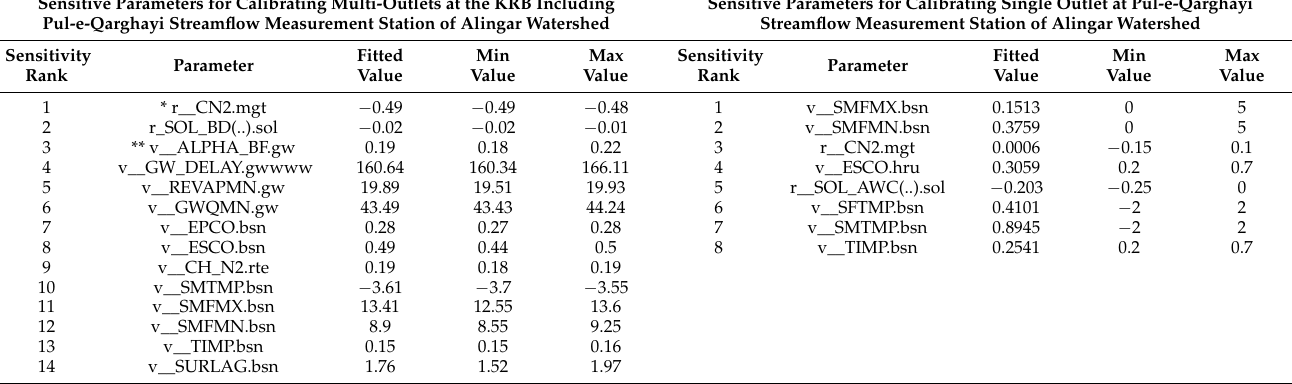
Table 6. A comparative analysis of the parameters used for sensitivity while simulating streamflow at multi and single